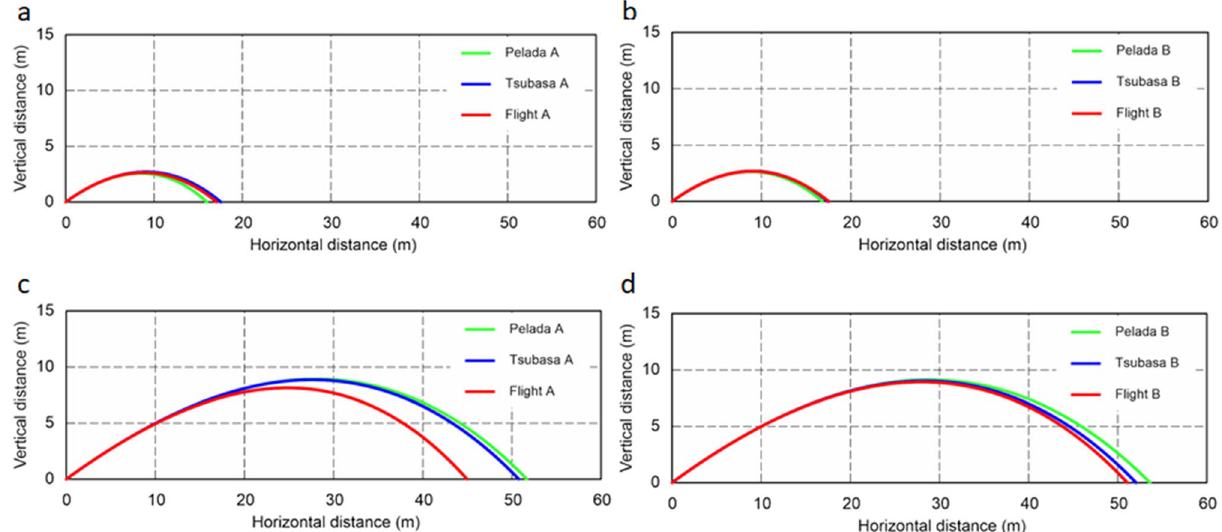
Figure 4. Comparison of the flight trajectories for Flight 2020, Tsubasa 2020, and Pelada 2020: ( a ) symmetric and ( b ) asymmetric orientations in the critical regime (initial ball speed of 15 m/s; Re = 2.1 × 10 5 ); ( c ) symmetric and ( d ) asymmetric orientations in the supercritical regime (initial ball speed of 30 m/s; Re = 4.2 × 10 5